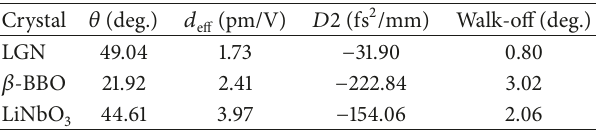
Table1:Calculationparametersfordifferentcrystalsinthe2.108 𝜇 m OPA pumped at 1.064 𝜇